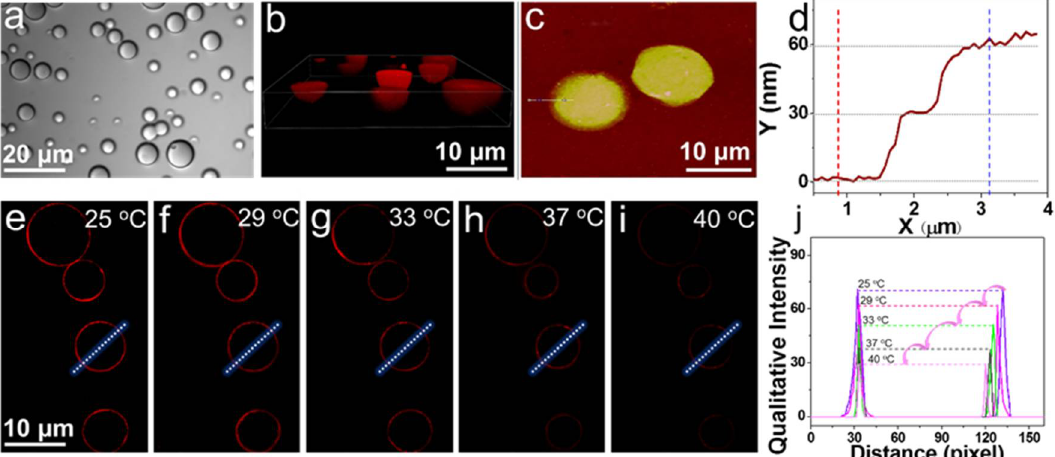
Figure 4. ( a ) Optical microscope image and ( b ) 3D CLSM image of Au NCs-PNIPAAm vesicles. ( c ) AFM images of the dry vesicles and ( d ) the corresponding section scanning of the films (red/blue line, the average value). ( e – i ) In-situ CLSM images of Au NCs-PNIPAAm vesicles from 25 to 40 °C showing the temperature-induced relay decrease in luminescence intensity accompanied by the decrease in diameter. ( j ) Corresponding intensity profiles and diameter variation for single vesicle shown in ( e – i ).